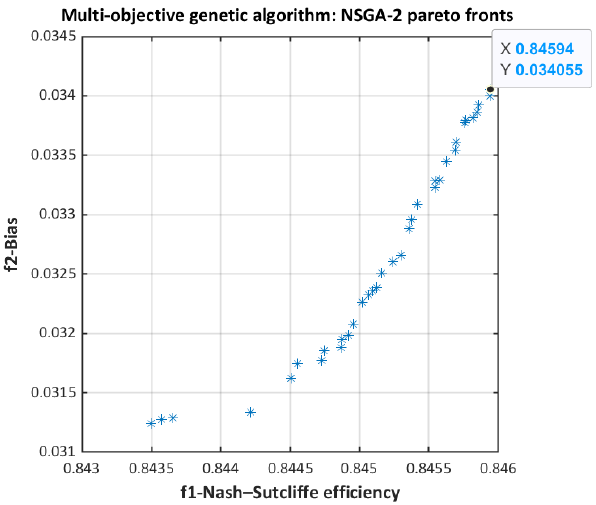
Figure 5. NSGA-II Pareto fronts of the model M01 over the Baska- tong catchment. Horizontal and vertical axis are NSE and bias, sep-